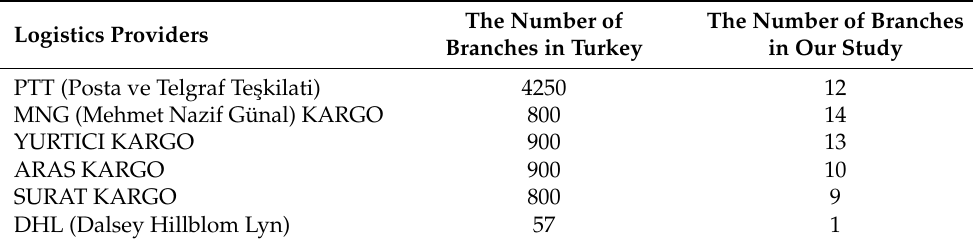
Table 1. Logistics service providers in